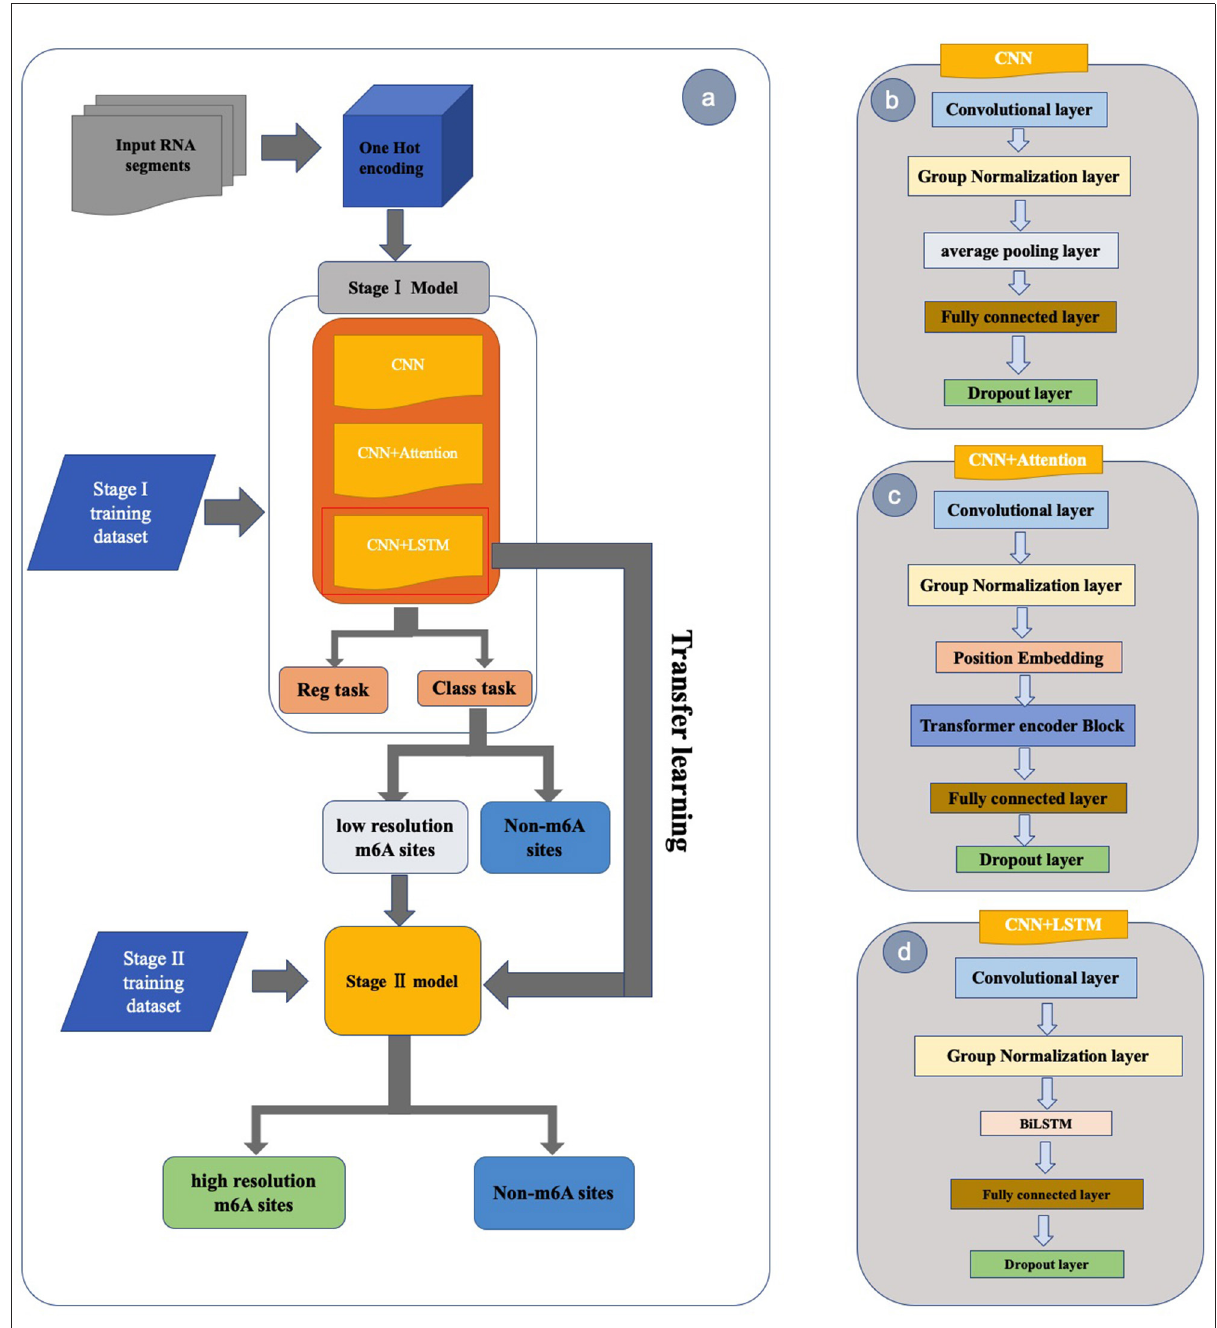
FIGURE2 The overall flow chart of MTDeepM6A-2S. (a) The diagram of the two-stage model. The stage I model is used to discriminate low-resolution m6A sites from non-m6A sites and the stage II model is used to identify high-resolution m6A sites from low-resolution m6A sites. Three deep networks were used to build the stage I model which are (b) CNN network, (c) CNN